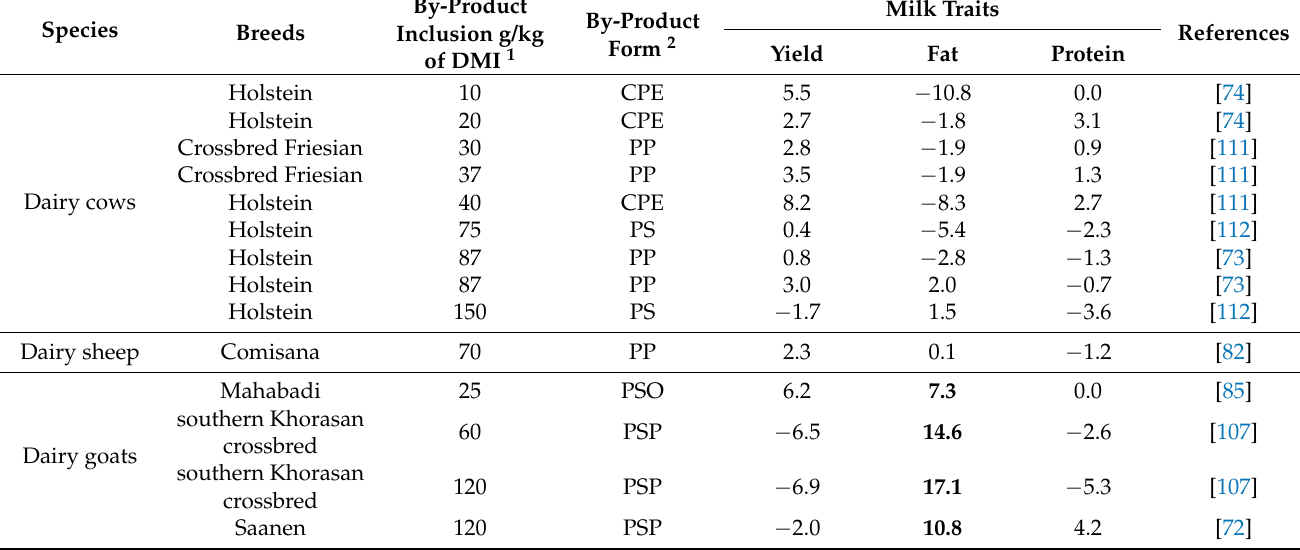
Bold values indicate significant differences ( p < 0.05) compared to the control group; 1 DMI = dry matter intake; 2 CPE = concentrate pomegranate extract; PP = pomegranate pulp; PS = pomegranate pulp silage; PSO = pomegranate seed oil; PSP = pomegranate seed